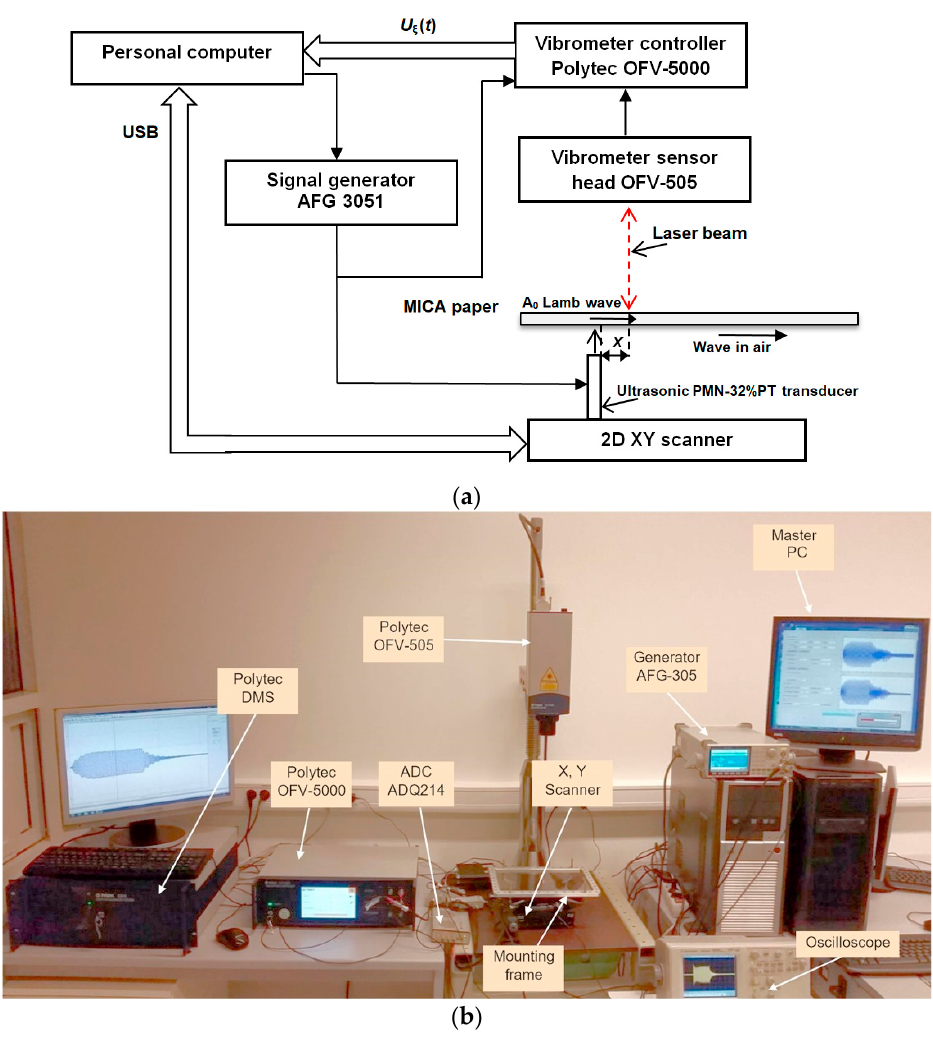
Figure 19. Experimental setup.